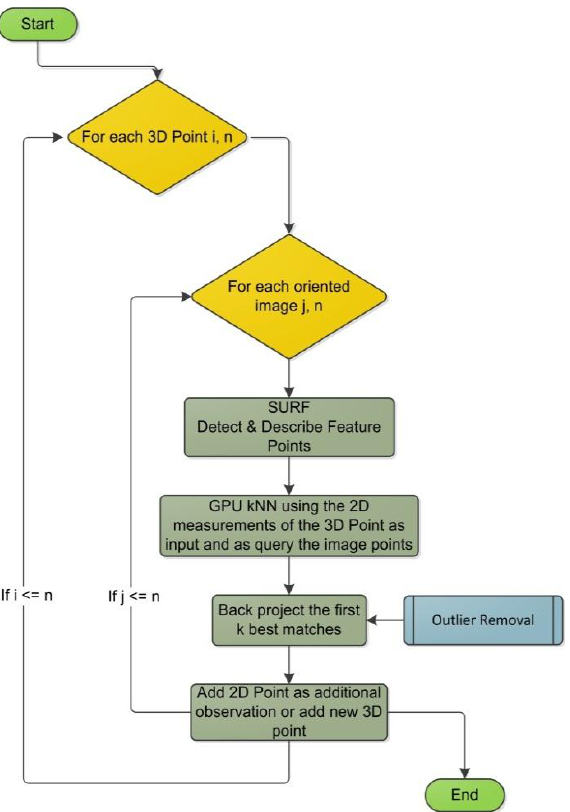
Figure 6. Flowchart of the proposed algorithm for adding new point or additional